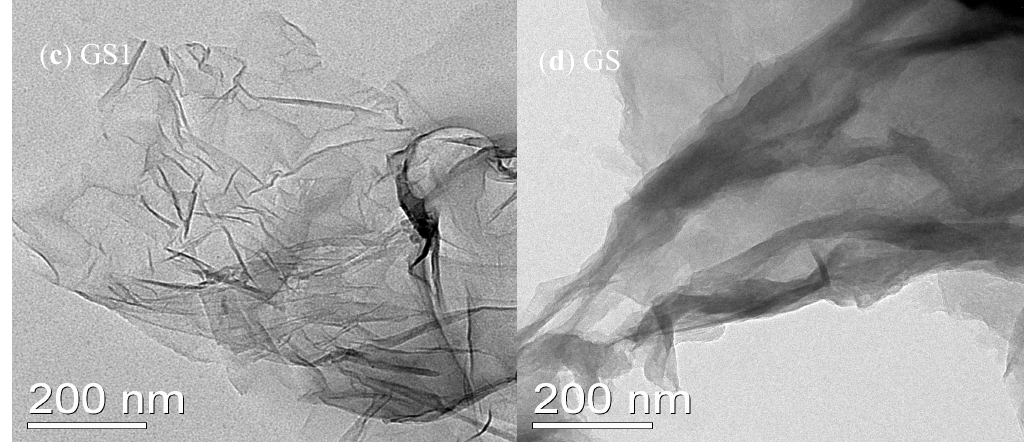
Figure 9. ( a , b ) SEM images and ( c , d ) TEM views of GS1 and GS.